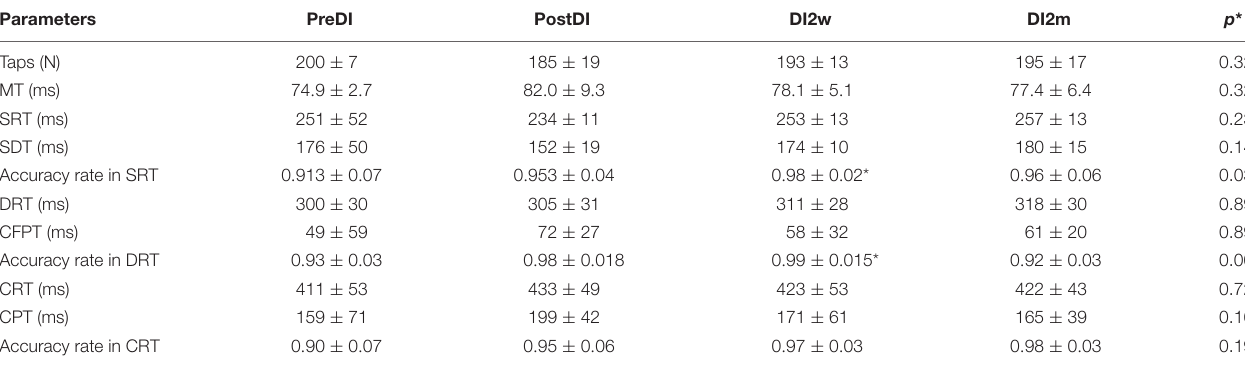
TABLE 4 | Numeral characteristics of the RT tasks across the program of DI in the “noDI” group of PD subjects. Parameters